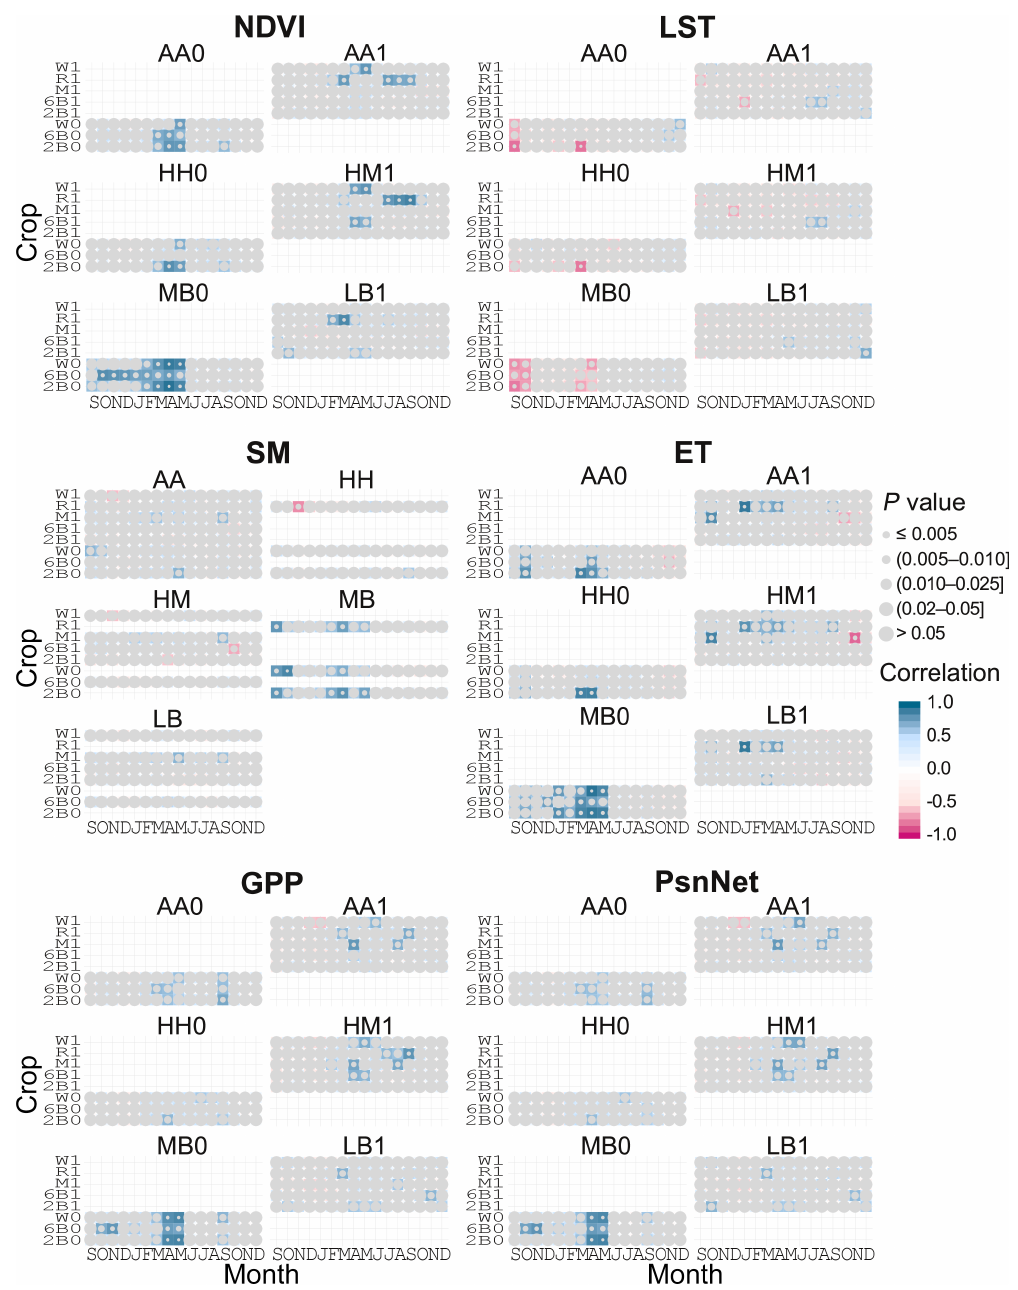
Figure 5. Correlation between remote sensing drought indicators and crop yield data. Rain-fed areas and crops are marked with 0 and irrigated areas and crops with 1. The crops are irrigated and rain-fed wheat (W1 and W0), irrigated rice (R1), irrigated maize (M1), irrigated and rain-fed six-row barley (6B1 and 6B0) and irrigated and rain-fed two-row barley (2B1 and